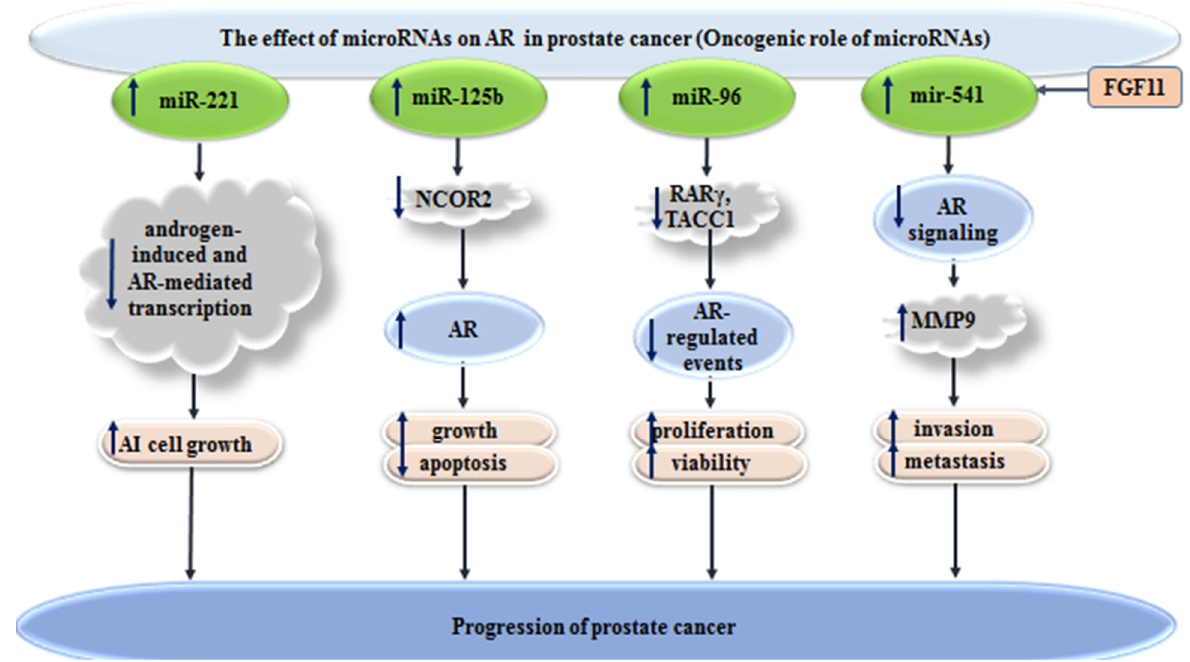
Figure 2. Effects of oncogenic miRNAs in progression of prostate cancer, through the modulation of AR signaling ( in- creased levels of, decreased levels of).